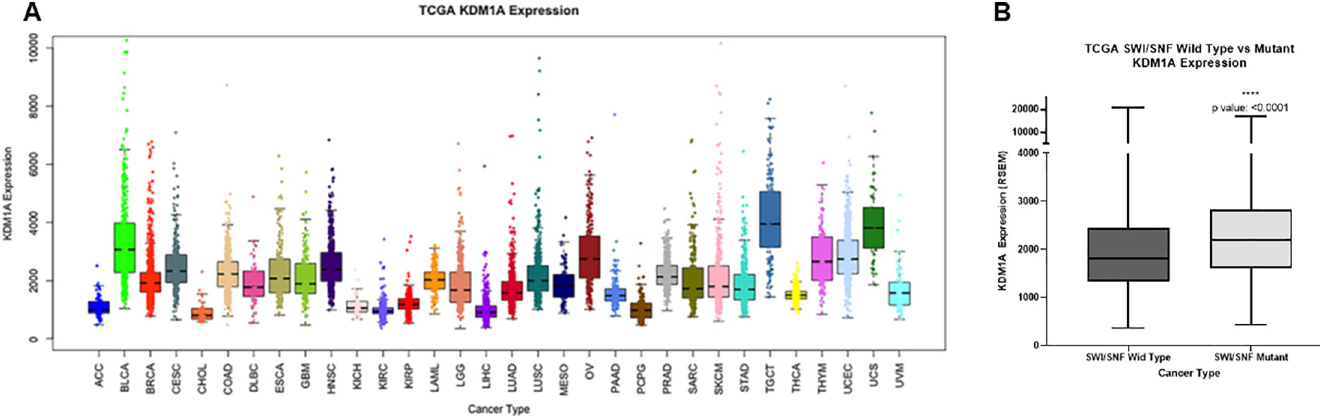
Fig 1. LSD1 expression in tumors and SP-2577 toxicity in SWI/SNF mutated tumors. ( A ) TCGA analysis for LSD1 expression in different human cancers. The cancer type acronym to full cancer type key from TCGA PanCancer Atlas is in S2 Table. (B) TCGA analysis for LSD1 expression in SWI/SNF-mutated tumors.